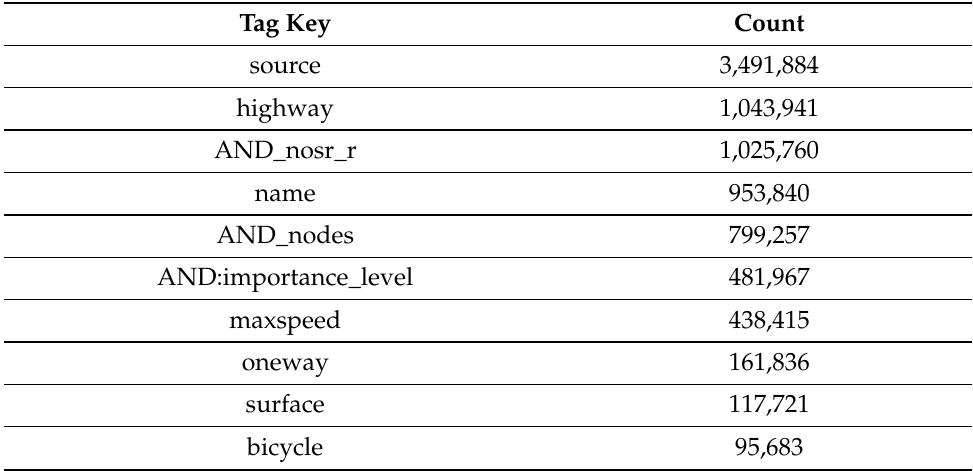
Table 3. The ten commonest tag keys in September 2007 in the Netherlands. Tag